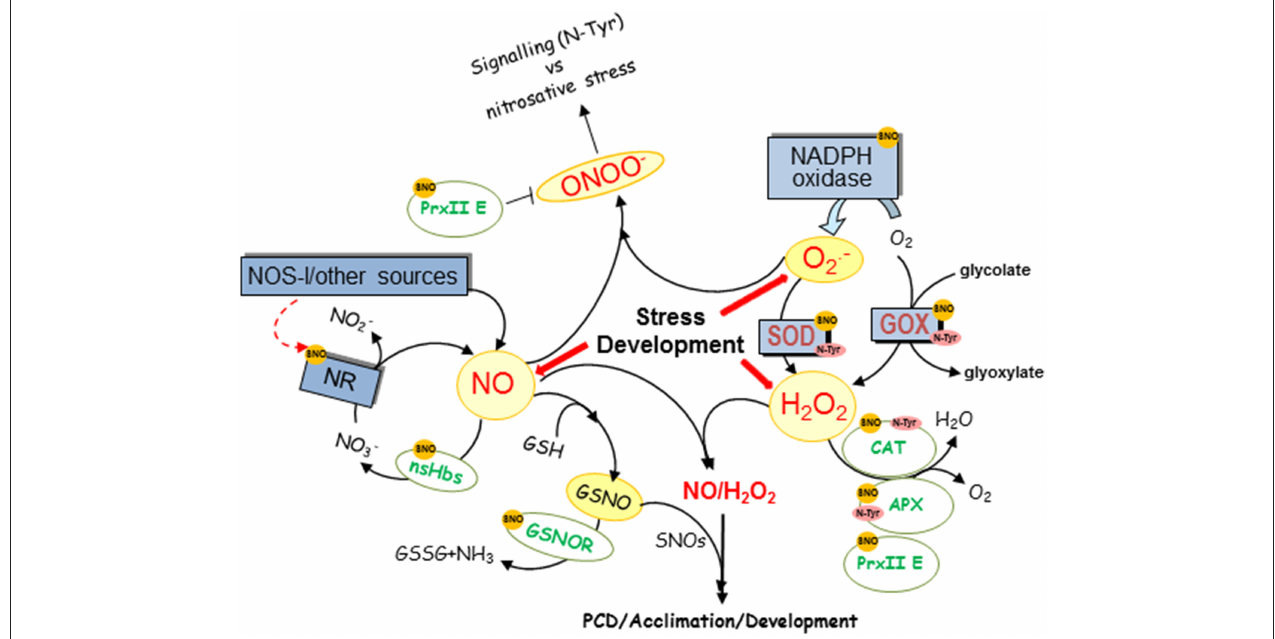
FIGURE 1 | Overview of NO and ROS level regulation by NO. NO regulates through posttranslational modifications (PTMs), NO and ROS producing and scavenging enzymes and the figure shows a diagram of the main targets of S-nitrosylation (SNO), nitrosylation (Haem-NO), or nitration (N-Tyr) described in plants. CAT, catalase; GSH, glutathione; GOX, glycolate oxidase; GSNO, nitrosoglutathione, GSNOR, GSNO reductase; nsHbs, non-symbiotic hemoglobins; NOS-l, activity that resembles NO production as catalyzed by the animal enzyme NOS; NiNOR, plasma membrane-bound NiNOR; NR, nitrate reductase; XOR, xanthine